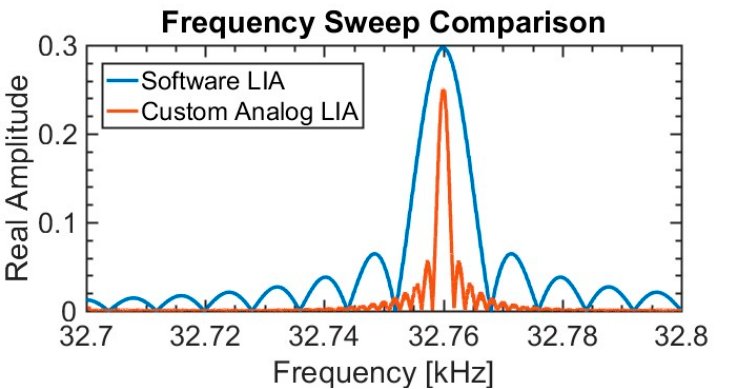
Figure 3. Comparison plot between Software and Analog LIA, locked frequency at 32.76